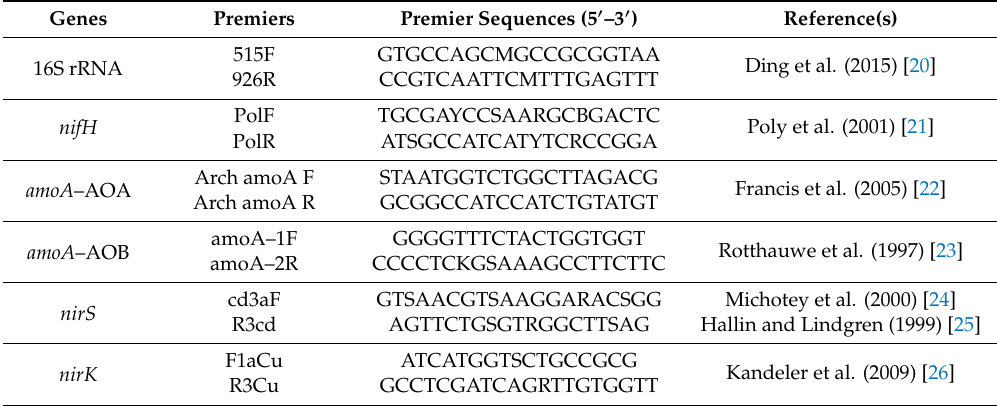
Table 1. Primer pairs used for gene detection in this